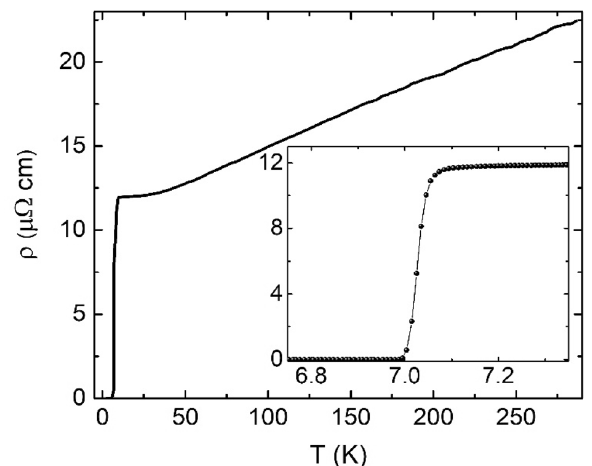
Figure 2. Resistivity, ρ , as a function of temperature, T , for a Nb(20)/MgO(3) sample measured using